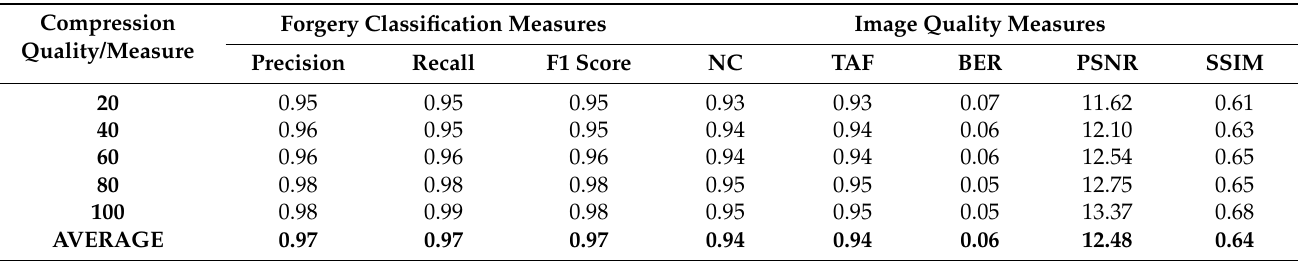
Table 2. Forgery classification and image quality measure values for the second group of experiments (Compression attack).